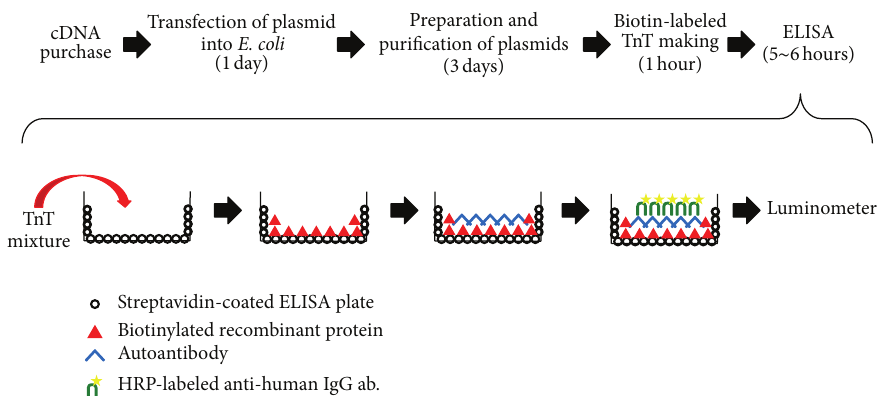
Figure 1: ELISA development using biotinylated recombinant protein. The process flow summarizes the method of ELISA construction, from obtaining the cDNA to obtaining the data by luminometer. We perform phenol/chloroform treatments twice to inhibit RNase for the plasmid purification.